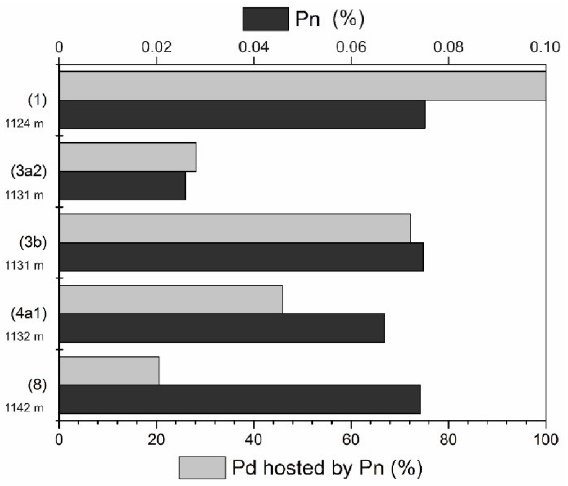
Figure 11. Calculated Pd proportion hosted by calculated pentlandite (data from Table 7).